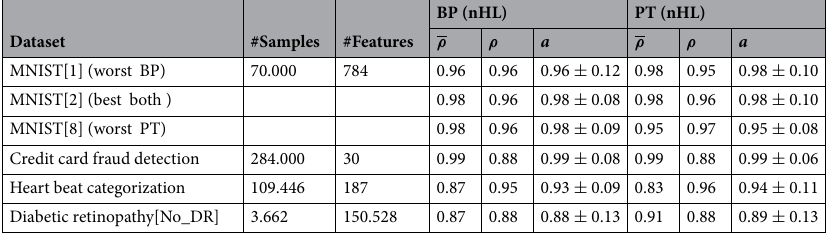
Table 3. Comparison, with focus on accuracy , between BP and PT—applied to medium-size datasets (all from the Kaggle ML repository). The comparison has been performed using the train-and-test strategy, as often done with datasets of significant size. Non binary datasets have been preventively binarized (for the sake of brevity, only the best and the worst cases have been reported for the dataset MNIST ). Experimental runs have been repeated 4 times. Also standard deviation is reported for